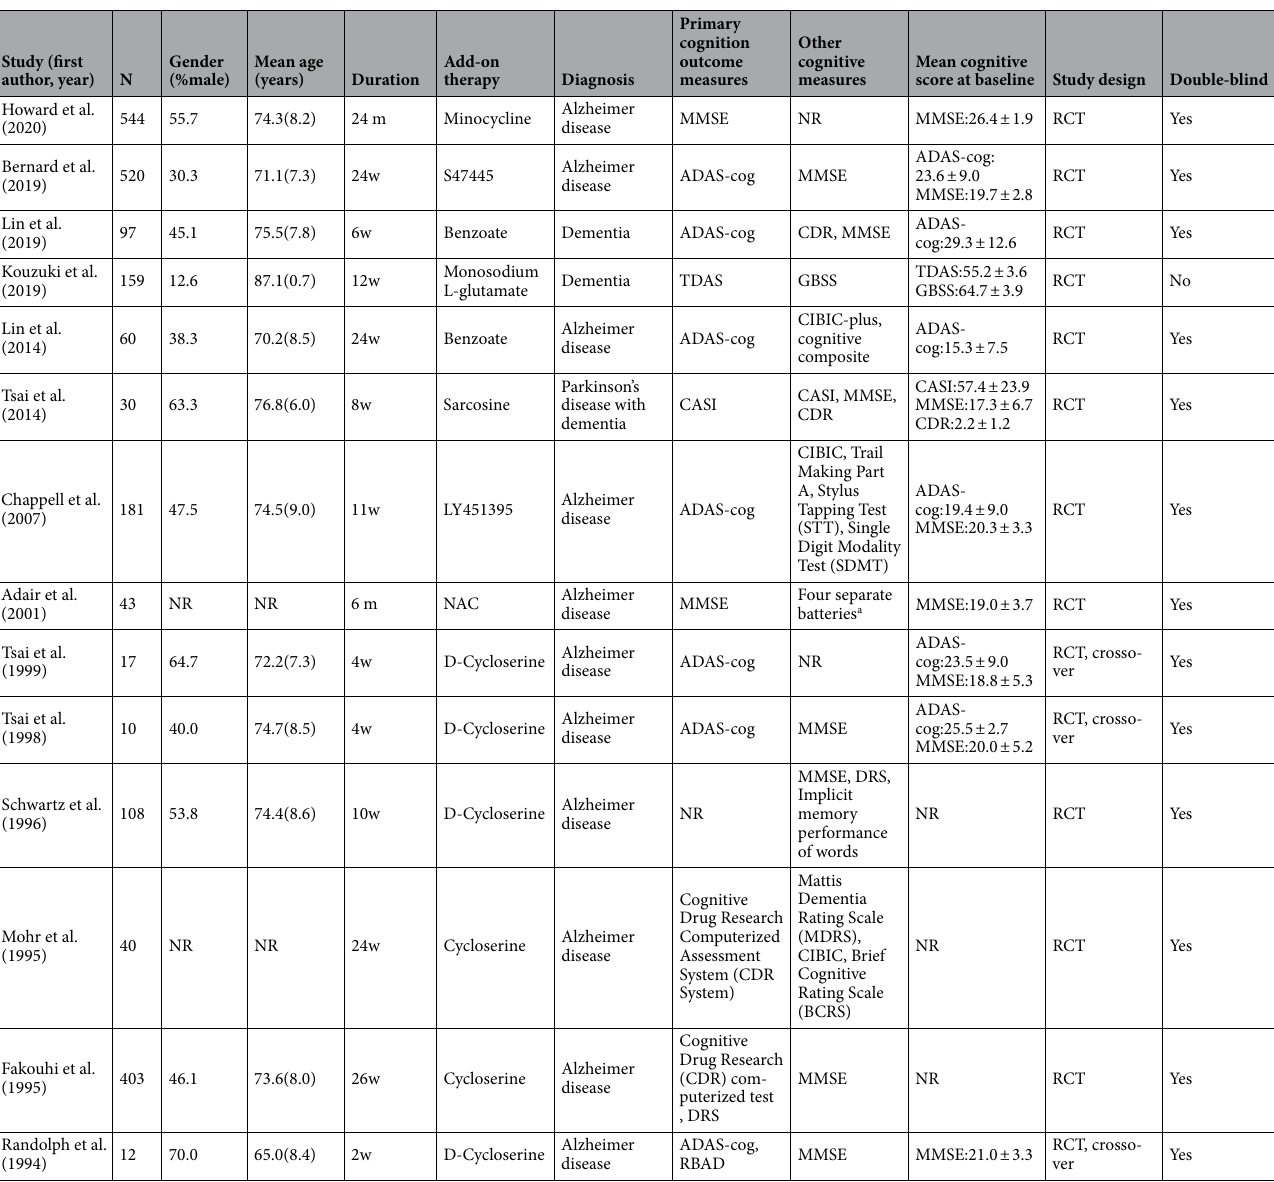
Table 1. Summary of the characteristics of studies included in the meta-analysis. ADAS-cog Alzheimer’s Disease Assessment Scale-cognitive subscale; CASI Cognitive Abilities Screening Instrument; CDR Clinical